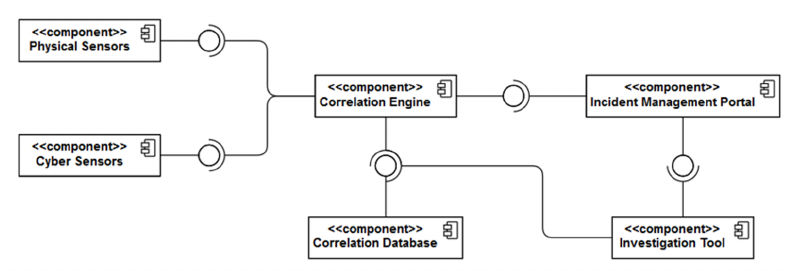
Figure 3. SATIE security ecosystem with SMS-I.